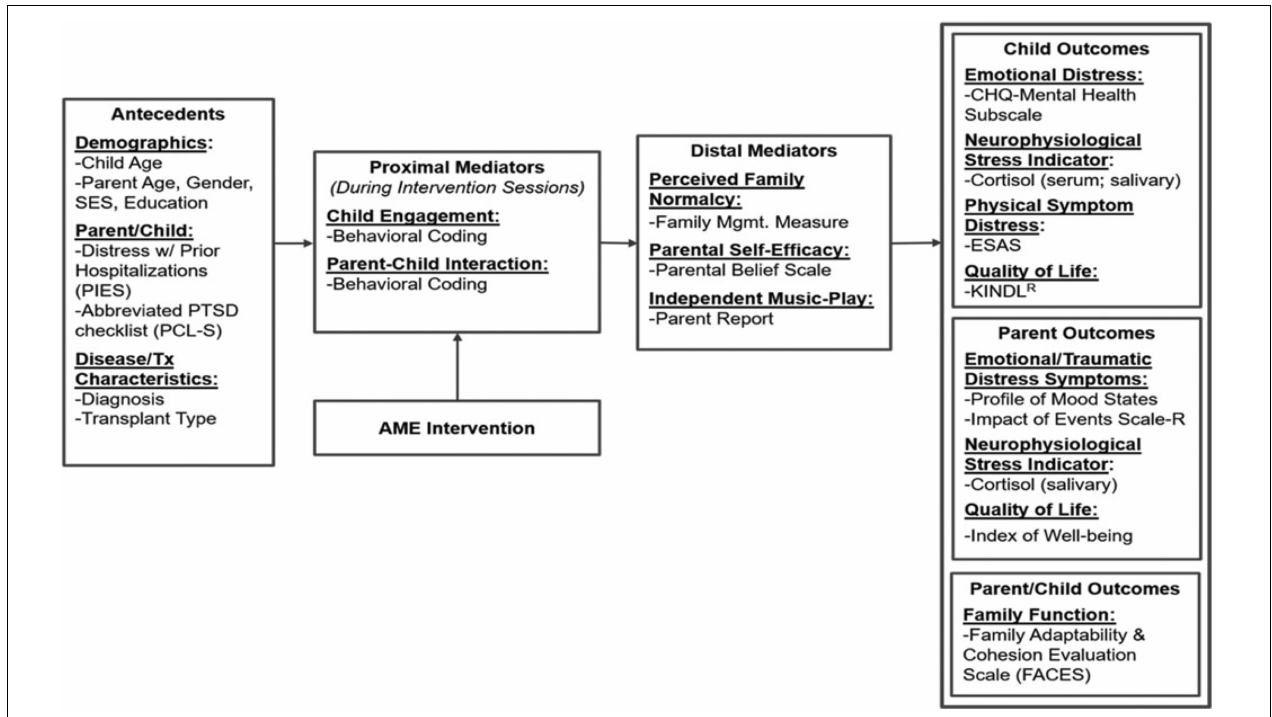
FIGURE 1 | Conceptual framework. Reprinted from Russ et al.